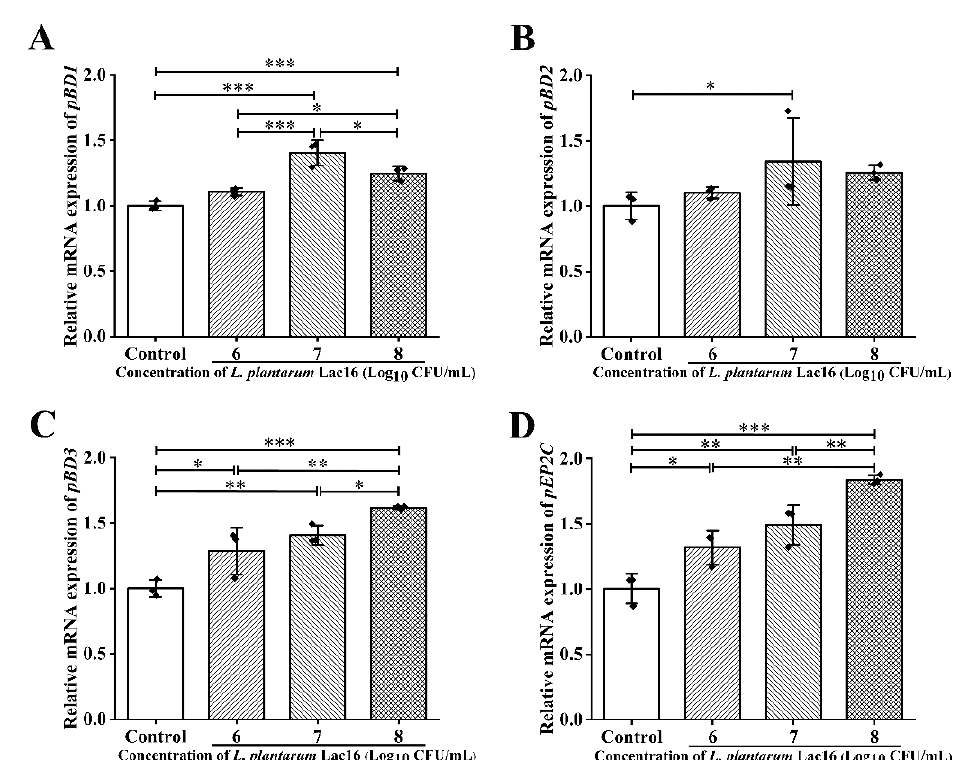
Figure 2. Gene expression levels of HDPs in L. plantarum Lac16-treated IPEC-J2 cells. ( A ) pBD1 , ( B ) pBD2 , ( C ) pBD3 , ( D ) pEP2C . mRNA expression was standardized to β-actin expression. Data are presented as the means ± SD for n = 3; * p < 0.05, ** p < 0.01, *** p < 0.001 (one-way ANOVA).